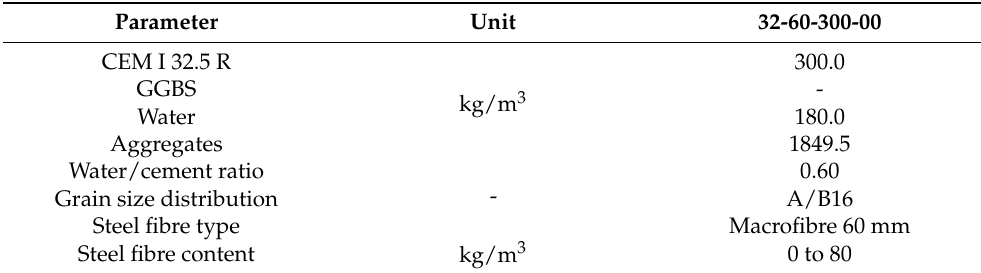
Table 3. Concrete mix design of the basic